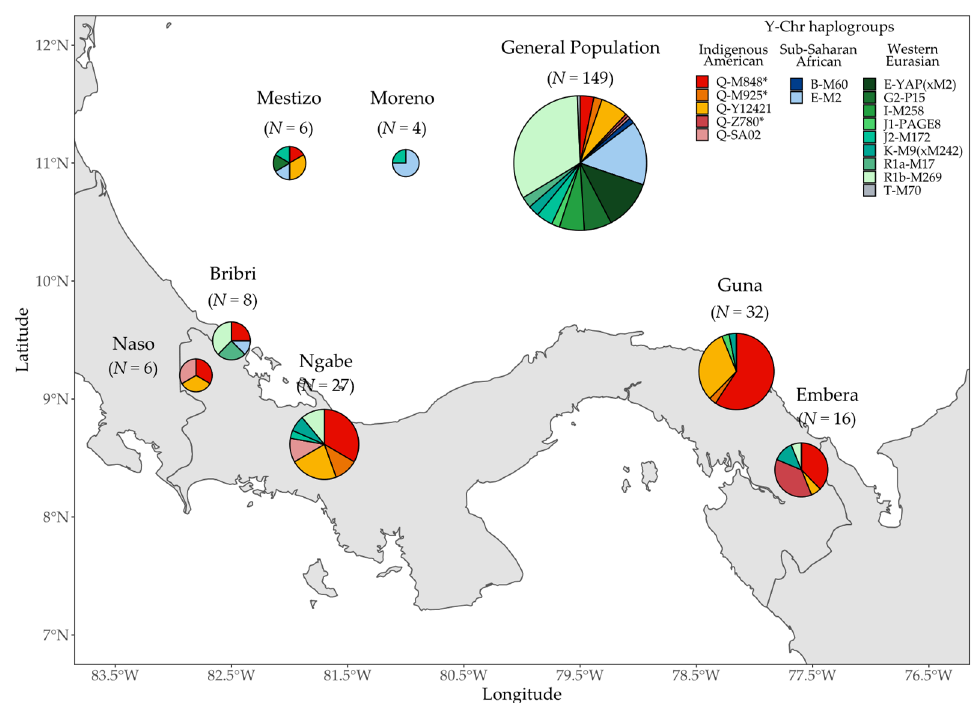
Figure 2. Map showing the haplogroup distribution of the 248 Y chromosomes according to the self-reported affiliation of the participants in the study (see Figure 1 for further details).